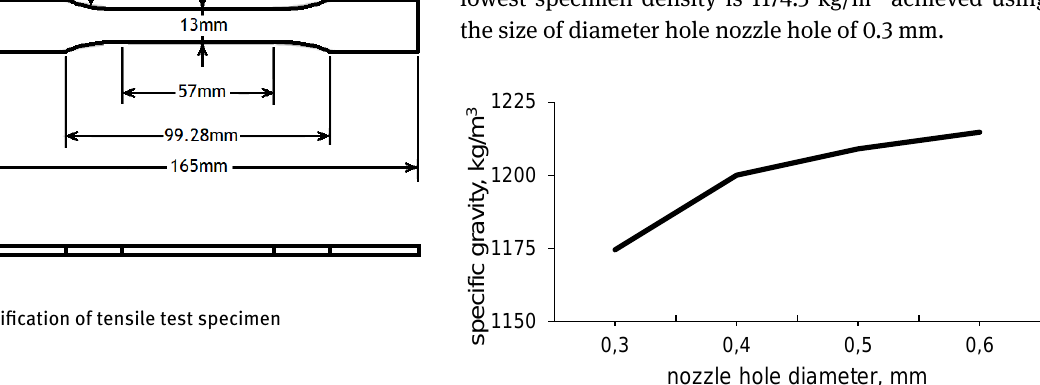
Tensile test is performed with universal testing ma- chine from JTM Technology to get the tensile strength of specimens with equation of [26]: